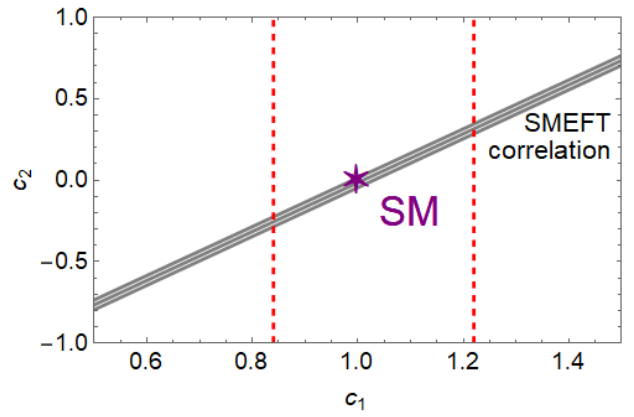
Figure 3. The correlation = 3 Δ a c ( c 1 − 1) − 1 2 1 pre- 2 4 dicted by SMEFT at O (1 / Λ 2 ) in the top Yukawa sector of HEFT. The 95% confidence in- terval for the coupling c 1 ∈ [0 . 84 , 1 . 22] is taken from [18] (red dashed lines). The experi- mental uncertainty [16, 19] on a / 2 ∈ [0 . 97 , 1 . 09] a 1 , namely 1 (at 95% CL), is reflected in the width of the gray band with the SMEFT correlation.